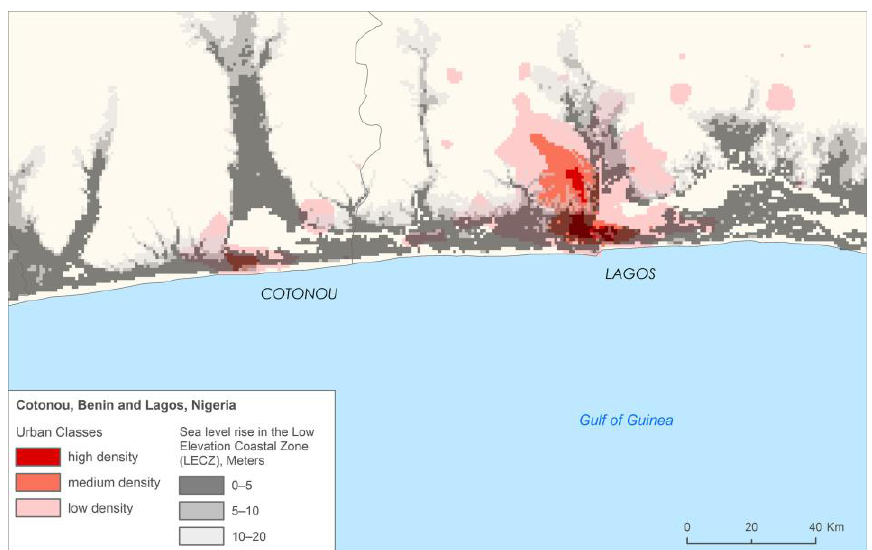
Figure 7. Urban areas of Cotonou, Benin and Lagos, Nigeria in comparison to the LECZ.